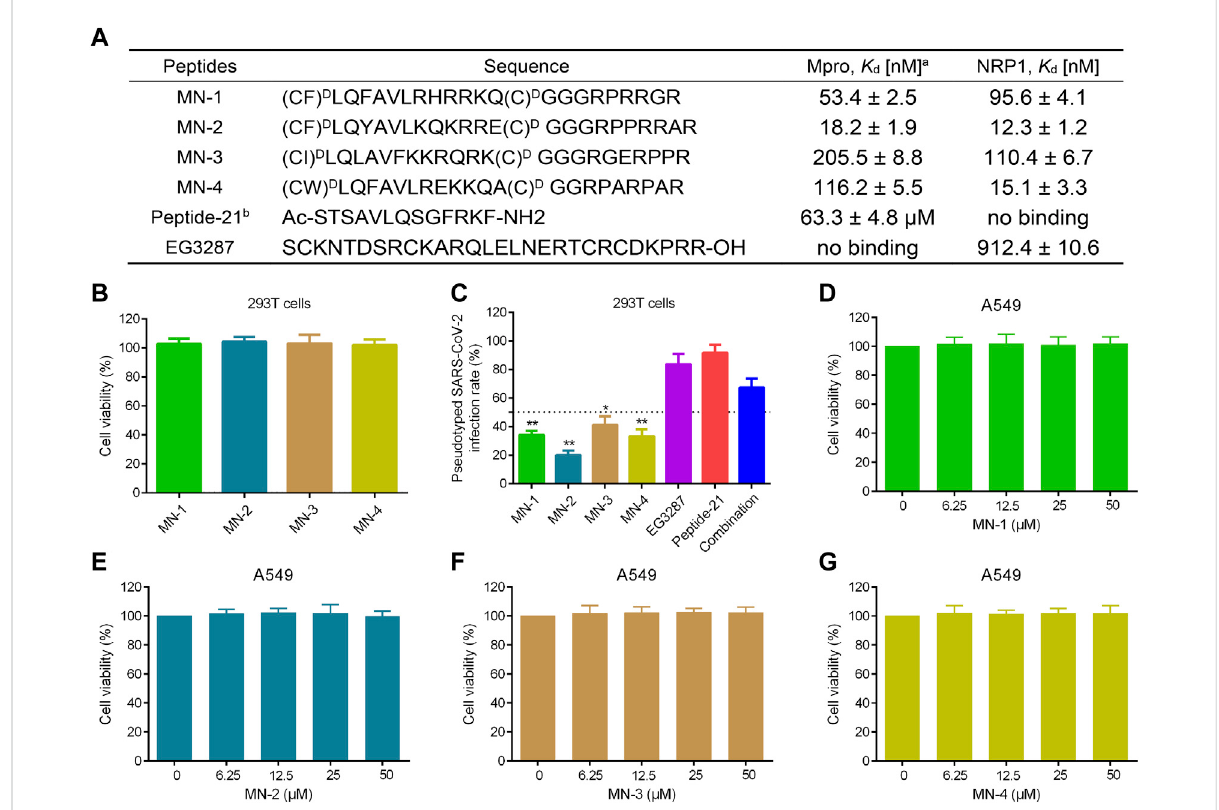
FIGURE 7 Binding af fi nity, anti-pseudovirus infection, and cytotoxicity of MNs 1-4. (A) Sequences and binding af fi nities of peptides. a MST data shown represent the mean ± SD ( n = 3). b Peptide-21 and EG3287 served as the positive controls. MNs 1-4 were cyclized through a disul fi de bond formed by two cysteines. (B) The cytotoxicity effects of MNs 1-4 on 293T cells using MTT assay. (C) Infection rate of the screened peptides MNs 1-4, EG3287, Peptide-21, and the combination of EG3287 and Peptide-21 against pseudotyped SARS-CoV-2 Omicron BA.2.75 at a concentration of 2 μ M in 293T cells. (D – G) The cytotoxicity effects of MNs 1-4 on A549 cells detected using MTT assay. Cells were treated with different concentrations (0 – 50 μ M)ofpeptidesfor48 h.Theresultsarerepresentedasmean±SD( n =3).* p < 0.05,** p < 0.01meansasigni fi cantdifference versus